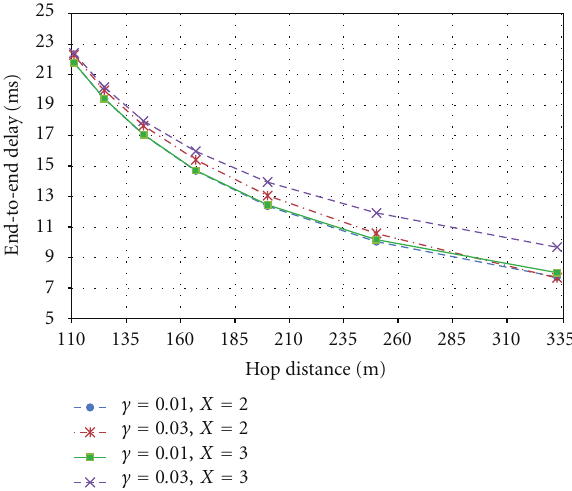
Figure 4: Average end-to-end delay versus hop